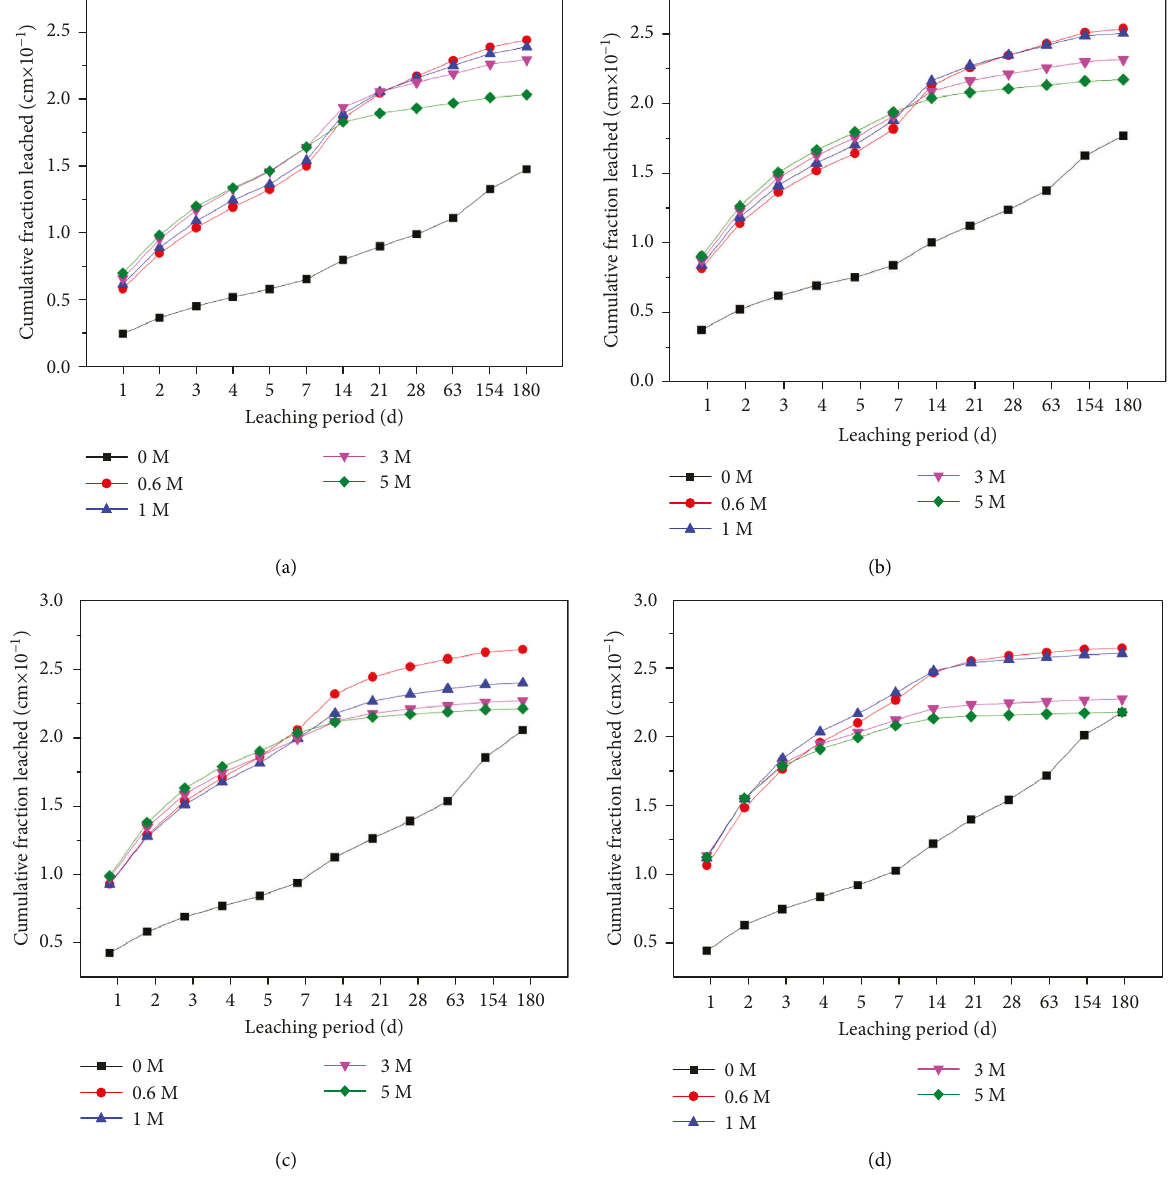
Figure 5: CFL of Na + in fly ash/cement waste forms under simultaneous effect: (a) 20 ° C; (b) 40 ° C; (c) 60 ° C; (d) 80 °